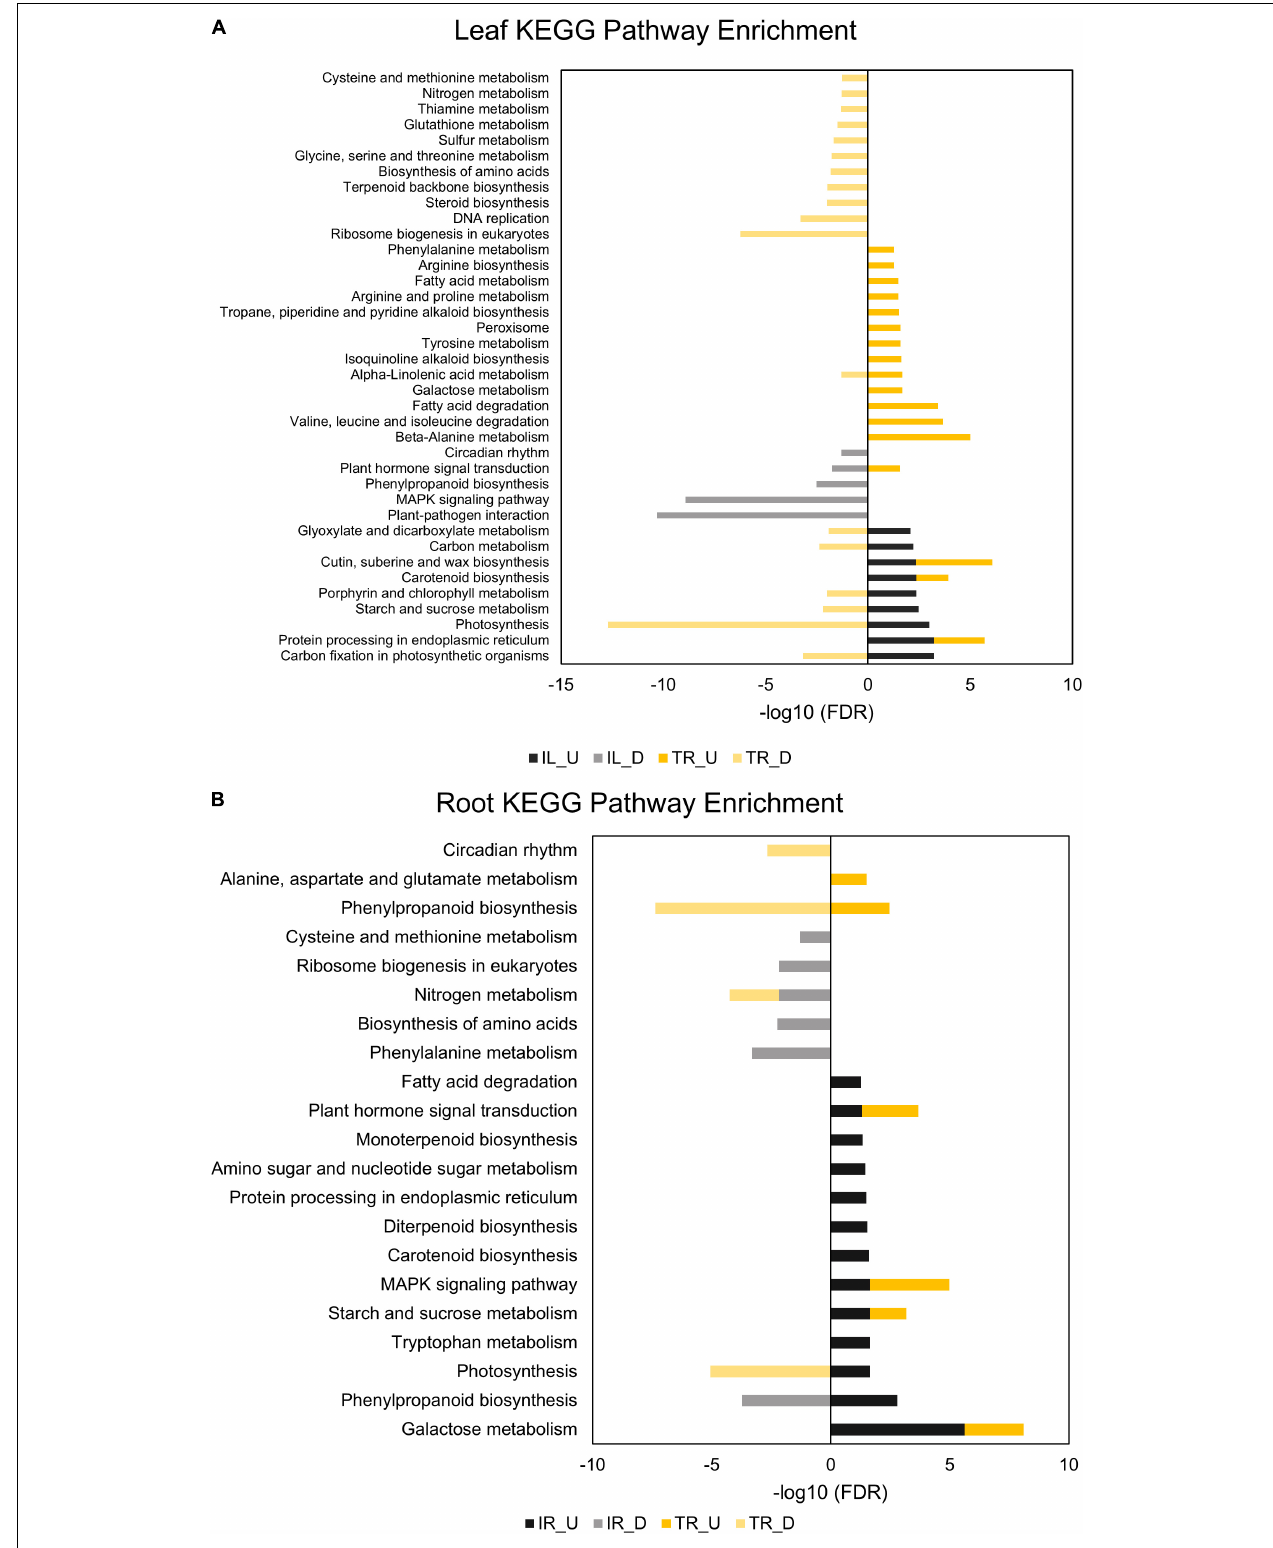
FIGURE 3 | KEGG pathway enrichment analyses of leaf (A) and root (B) DEGs. “U” depicts upregulated and “D” depicts downregulated DEGs in the legends of KEGG graphs. Performed for at least five genes in a pathway (adjusted p -value < 0.05).